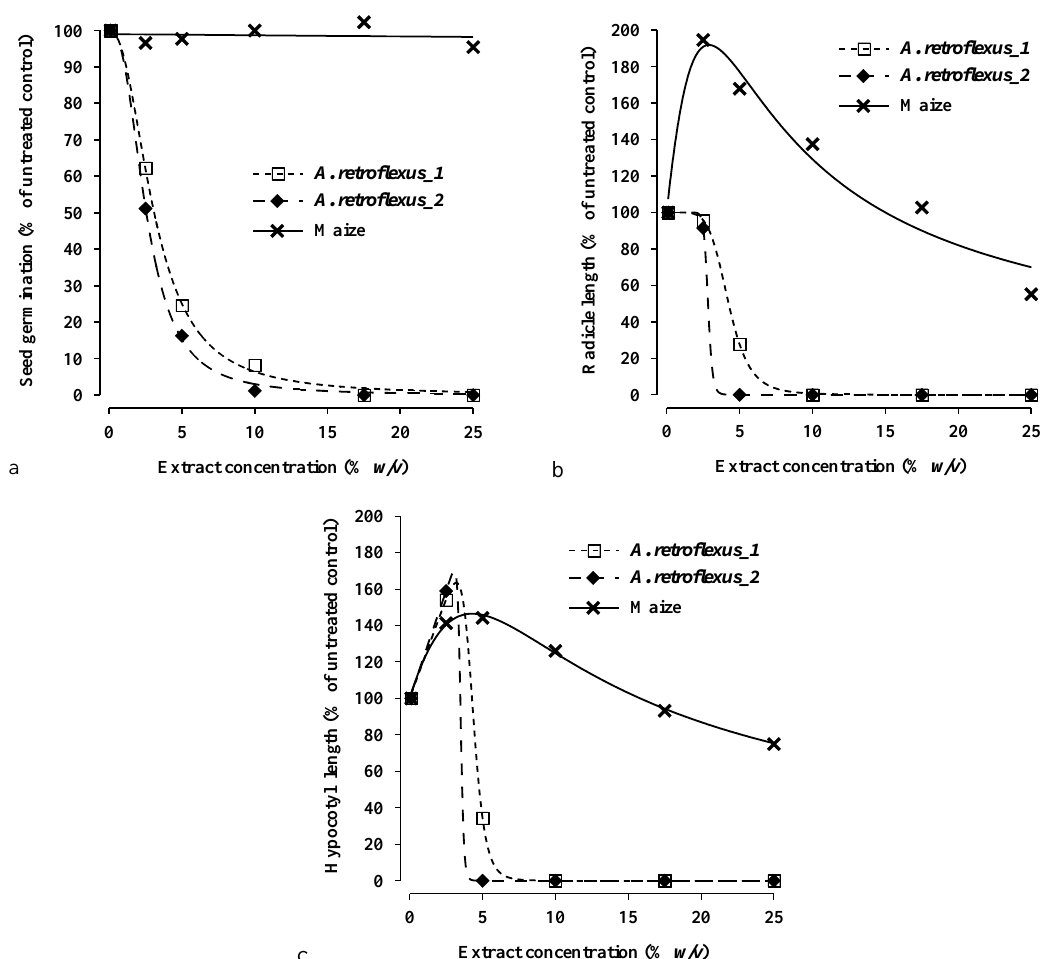
Figure 2. Effects of aerial biomass aqueous extracts of mugwort on seed germination (graphic a ), radicle length (graphic b ) and mesocotyl/hypocotyl length (graphic c ) of maize and redroot pigweed ( A. retroflexus ) seedlings (1 and 2 mean the two repeated bioassays). Symbols show observed data in the experiment 1, lines show fitted curves according to models 1 and 2.